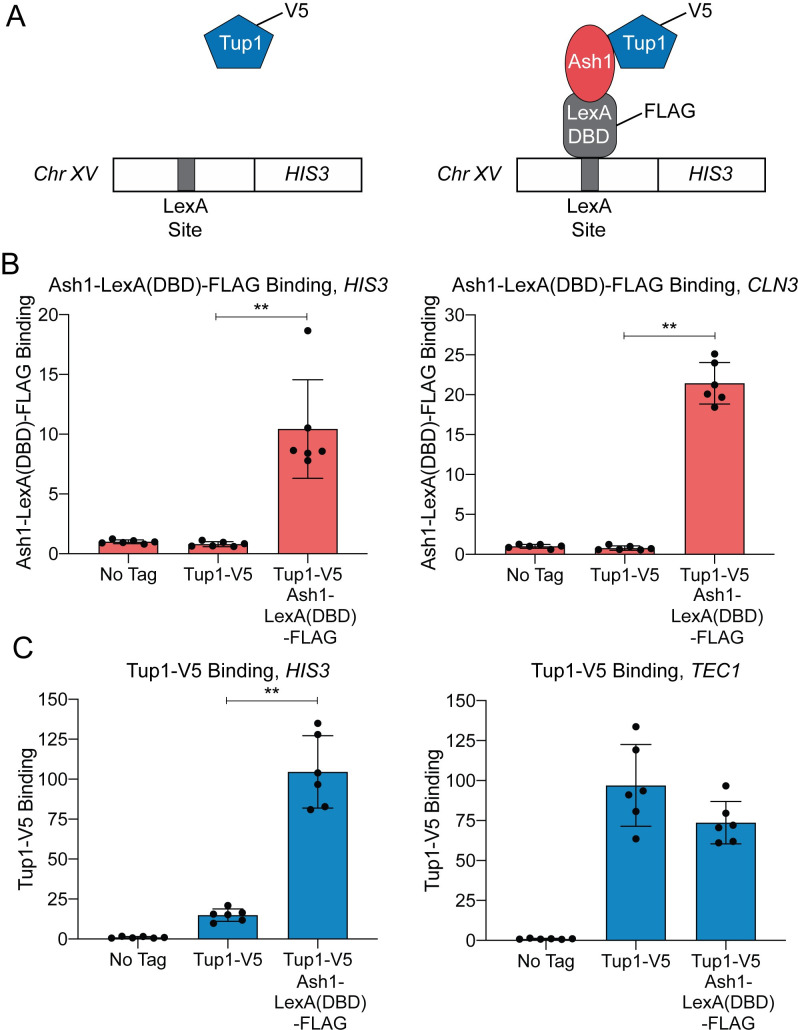
Ash1-LexA(DBD)-FLAG recruits Tup1-V5 to a LexA binding site on chromosome XV.(A) Schematic of experimental setup. Left–Strain with Tup1-V5 and LexA DNA-binding site integrated upstream of the HIS3 gene on chromosome XV. Right–Strain with additional integration of Ash1-LexA(DBD)-FLAG. Recruitment of Tup1-V5 by Ash1-LexA(DBD)-FLAG brings Tup1-V5 to the LexA binding site on chromosome XV. (B) Ash1-LexA(DBD)-FLAG associates with the HIS3 LexA site. ChIP analysis shows binding of Ash1-LexA(DBD)-FLAG to the LexA site upstream of HIS3 (left) and to a positive control site at CLN3 (right). Enrichment for each sample was normalized to its corresponding input DNA and a No Tag control. Each dot represents a single data point, and error bars reflect the standard deviation. ** p < 0.01. (C) Tup1-V5 is recruited to the HIS3 LexA site in a strain with Ash1-LexA(DBD)-FLAG. ChIP analysis shows binding of Tup1-V5 to the LexA site upstream of HIS3 (left) and to a positive control site at TEC1 (right). Enrichment for each sample was normalized to its corresponding input DNA and a No Tag control. Each dot represents a single data point, and error bars reflect the standard deviation. ** p < 0.01.